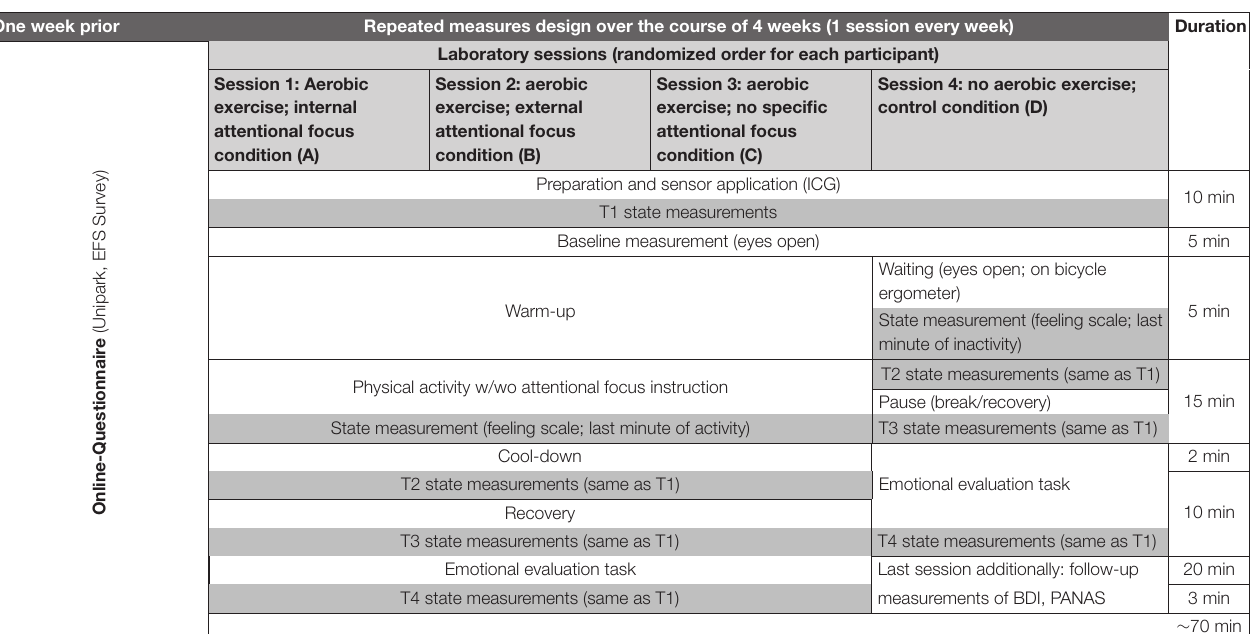
TABLE 1 | Experimental design; order of laboratory sessions has been randomized for every participant. One week prior Repeated measures design over the course of 4 weeks (1 session every